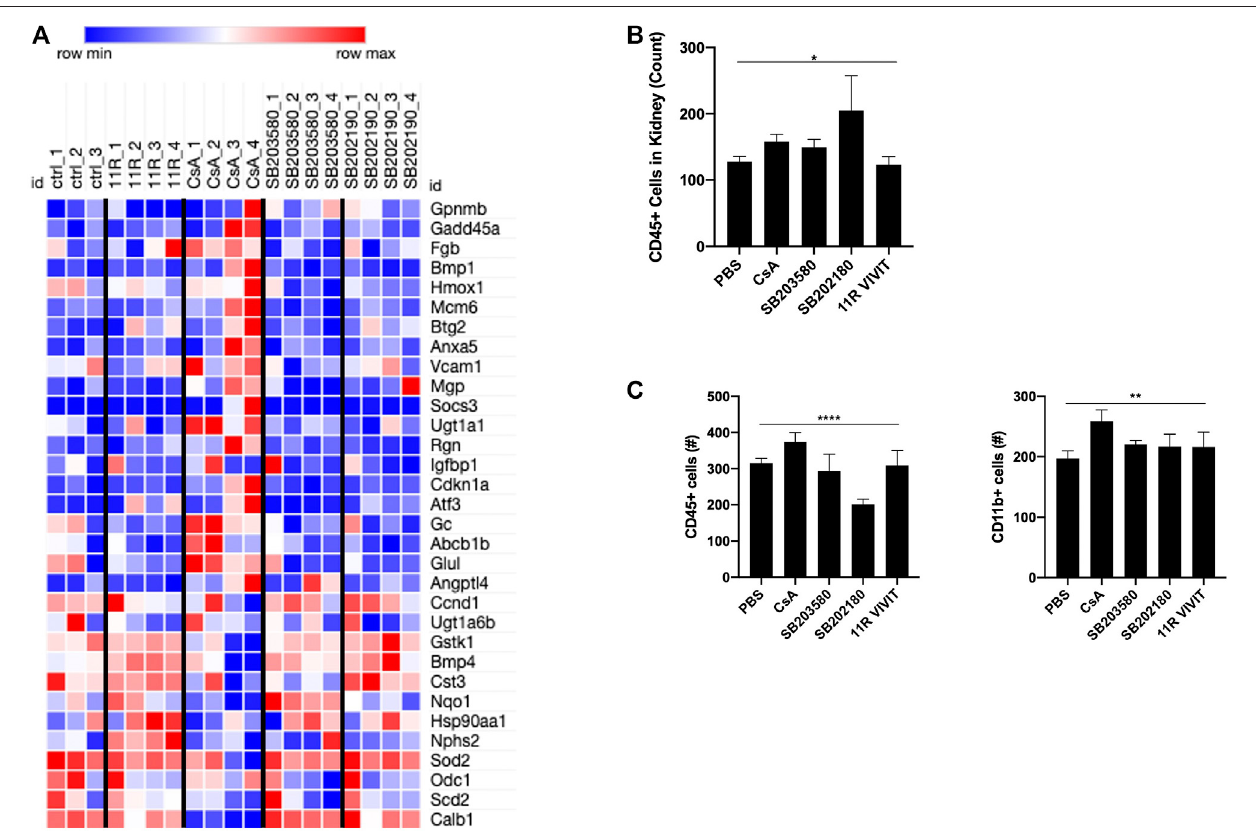
FIGURE 3 | In vivo experiments show the development of nephrotoxicity upon CsA and p38-kinase inhibitor. (A) Nephrotoxic gene array reveals evident upregulation of genes involved in nephrotoxicity upon CsA treatment. Also, both p38 inhibitors revealed upregulation of nephrotoxic genes (mouse kidney cells, RNAseq). (B) Higher CD45 +- in fi ltrated cells in the kidneys of CsA, SB203580, and SB202190 were detected. (C) Monocytic and lymphocytic cell compartments in the blood show a slight increase in cell number in animals treated with CsA and p38 MAPK inhibitors. B and C were measured by fl ow